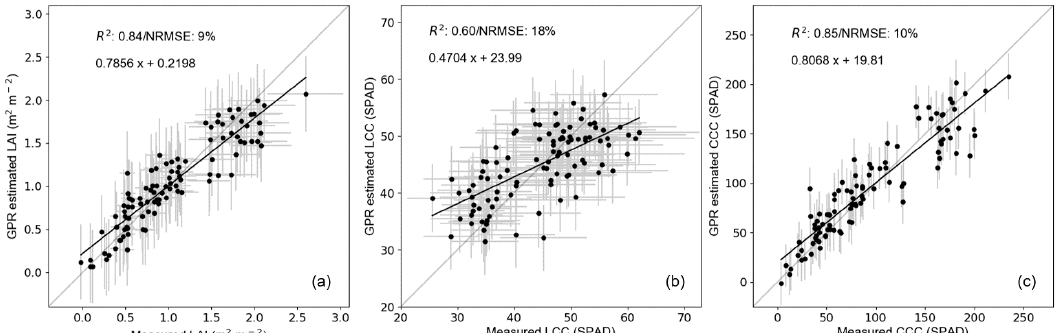
Figure 5. Independent GPR model evaluation for estimating ( a ) LAI, ( b ) LCC and ( c ) CCC. Note: Fit line (black line) is defined using reduced major axis where y -axis error bars are derived from the standard deviations of the GPR model estimates and x -axis error bars represent the standard deviations of the corresponding non-destructive ground measurements (available for LAI and LCC only).